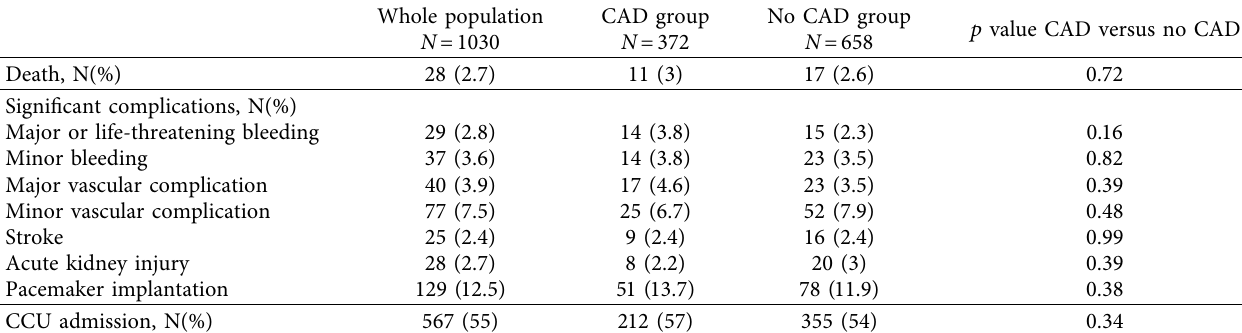
Table 2: Procedural adverse clinical outcomes stratified by the presence of concomitant coronary artery disease (CAD).